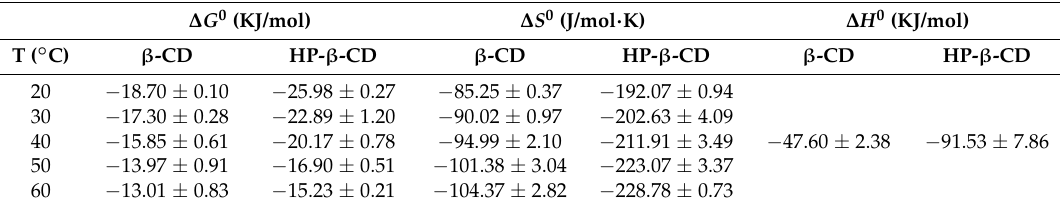
Table 1. Thermodynamic parameters for oxyresveratrol- β -CD and oxyresveratrol-HP- β -CD inclusion complexes from phase solubility diagrams at different